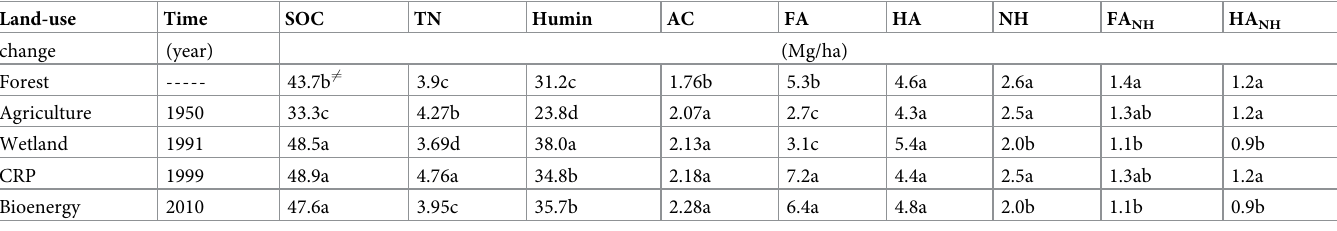
Table 4. Impact of deforestation and subsequent land-use diversity on total organic carbon (SOC), total nitrogen (TN), active carbon (AC), fulvic acid (FA), humic acid (HA), humin, and glucose equivalent total non-humic carbon (NH), fluvic acid associated glucose equivalent total non-humic carbon (FA NH ), and humic acid Land-use